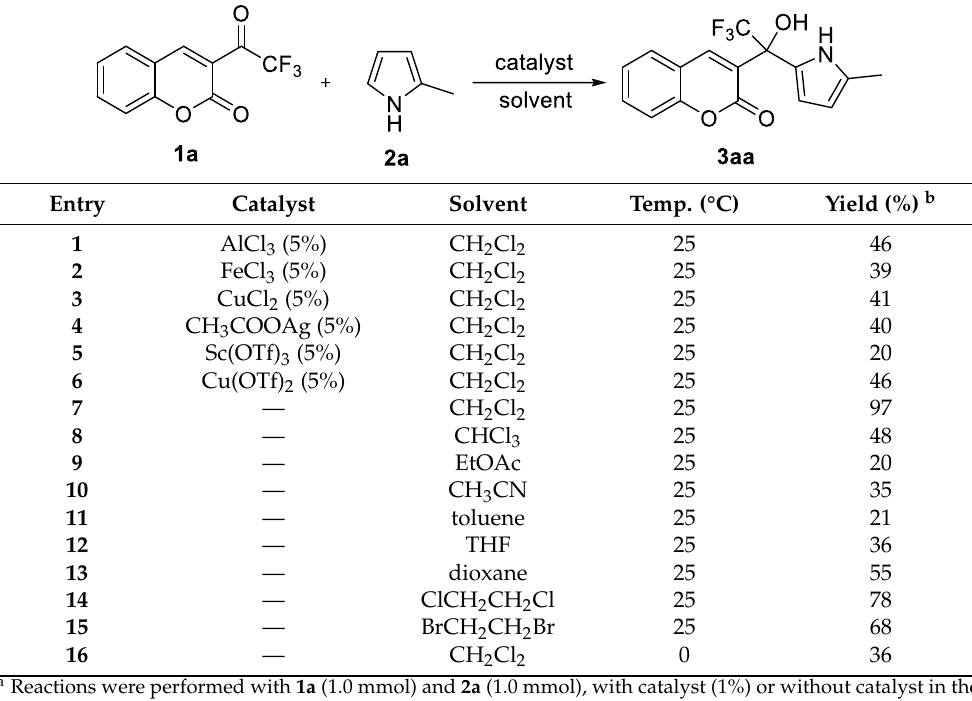
Table 1. Optimization of the reaction 3-(trifluoroacetyl)coumarin 1a and 2-methylpyrrole 2a a .